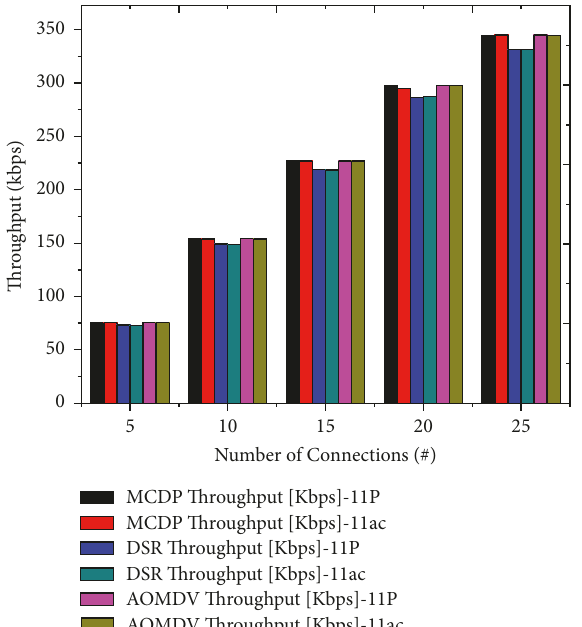
Figure 8: Throughput comparison of MCDP, DSR, and AOMDV protocols over 802.11P and 802.11ac with different numbers of connections.